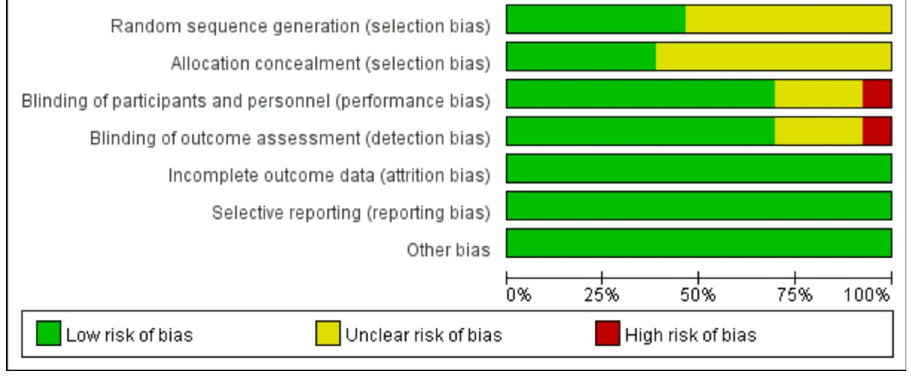
Fig 2. Risk of bias